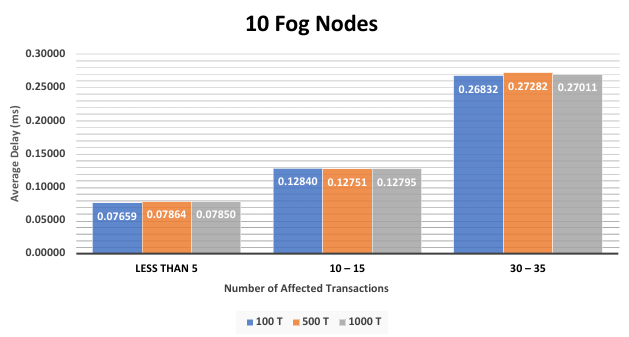
Figure A4. The impact of the different set of affected transactions on twenty fog nodes.